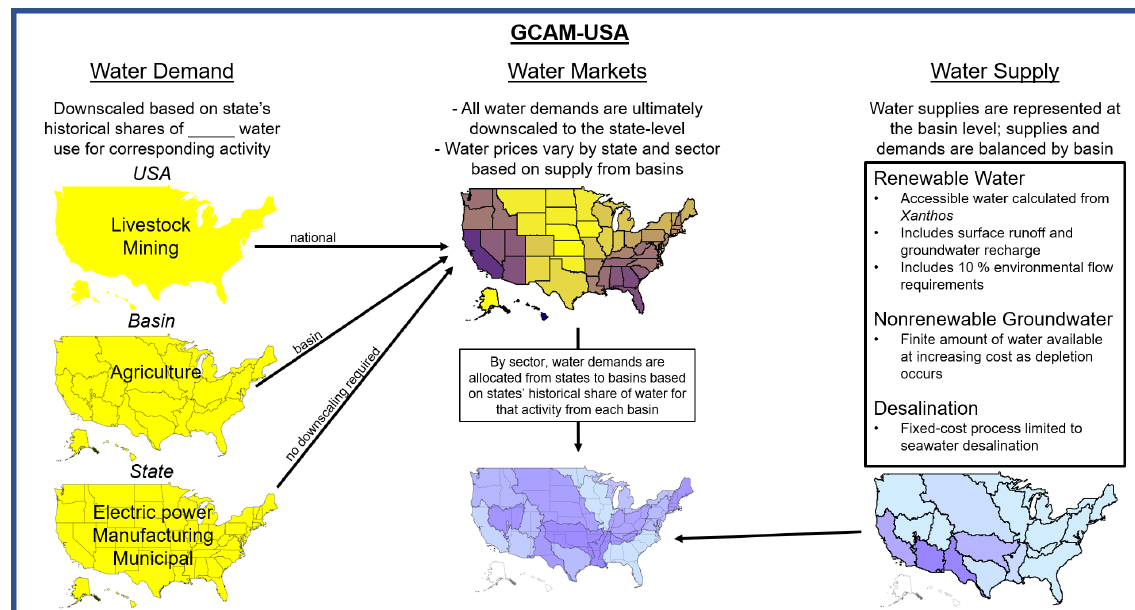
Figure 1. Conceptual diagram of GCAM-USA water market